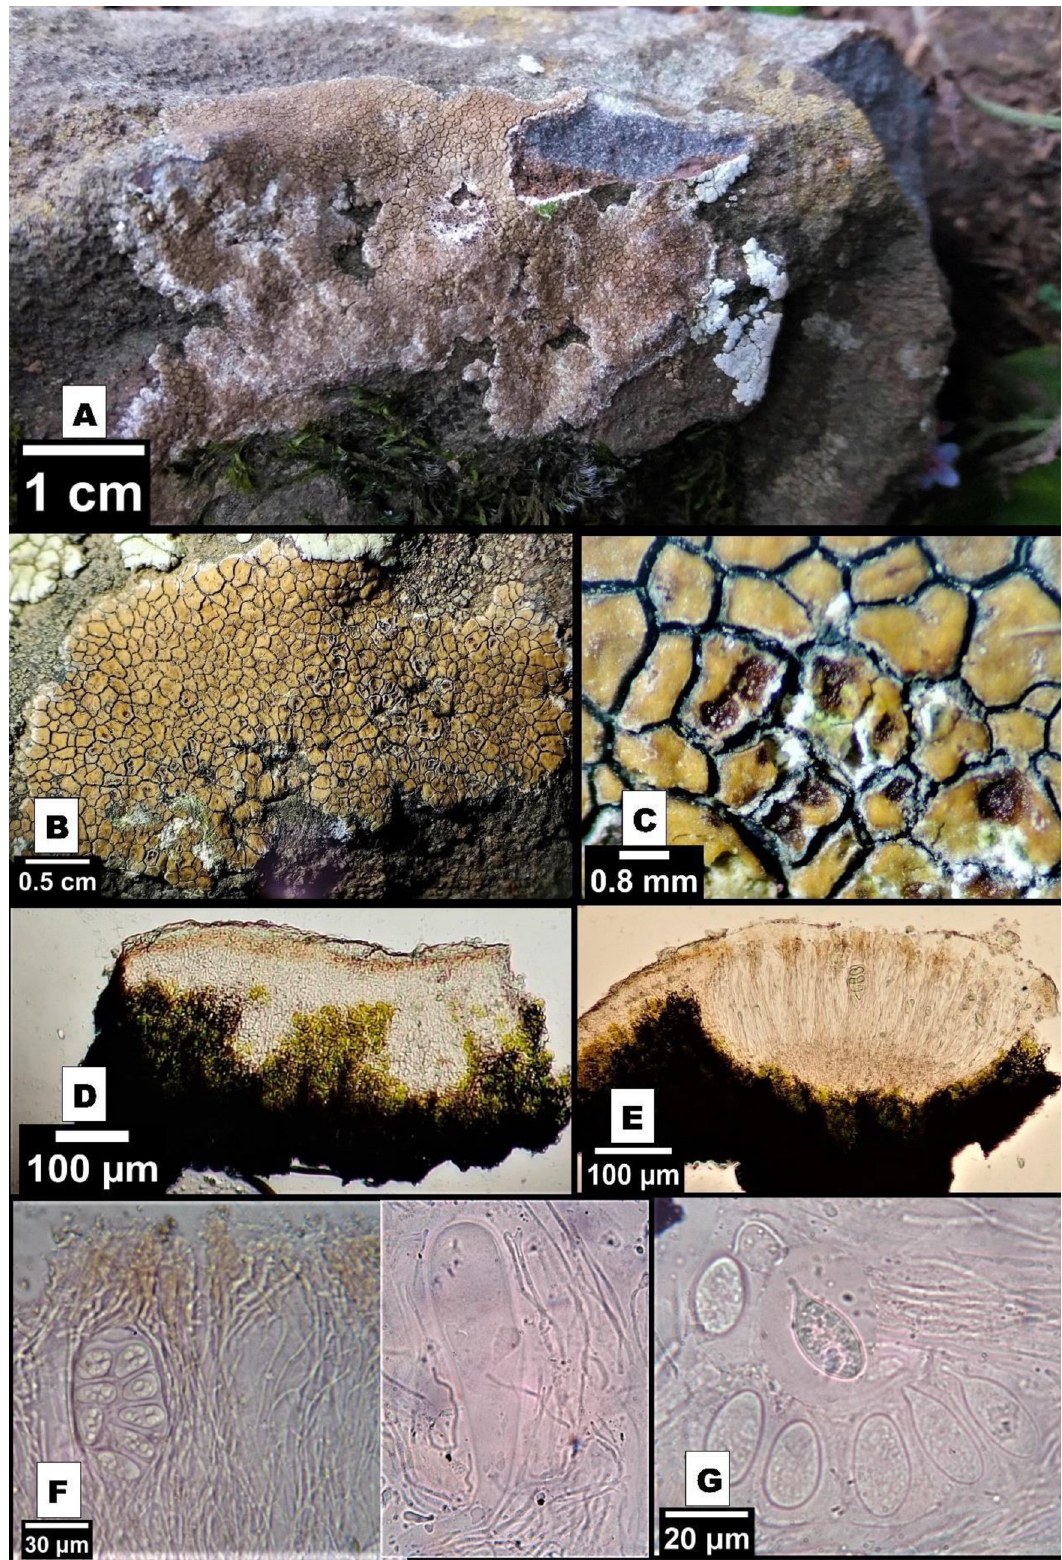
Fig. 2. Lecaimmeria pakistanica K.Habib, R.Zulfiqar & Khalid sp. nov. A . Areolate thallus. B . Wet thallus. C . Apothecia and areoles. D . Section of areole. E . Section of apothecium. F . Asci. G .